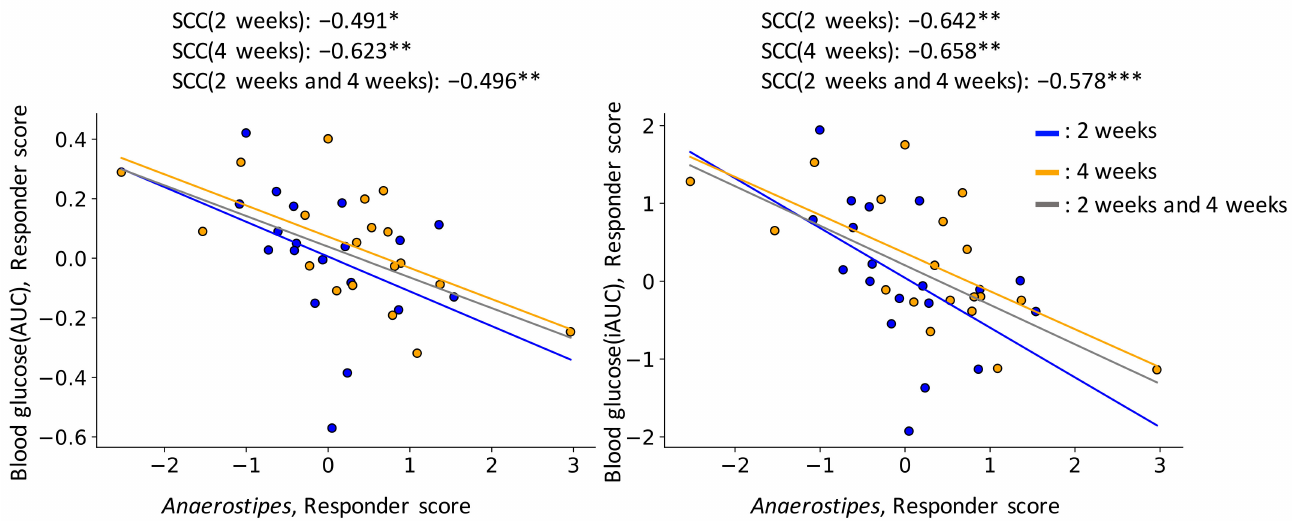
Figure 4. Increasing of Anaerostipes correlates with improved glucose tolerance. X axis indicates Anaerostipes responder score, and Y axis indicates blood glucose AUC/iAUC responder score. SCC indicates Spearman correlation coefficient and asterisks (*) indicate statistically significant correlated (no correlation test). *, p < 0.05; **, p < 0.01; ***, p <